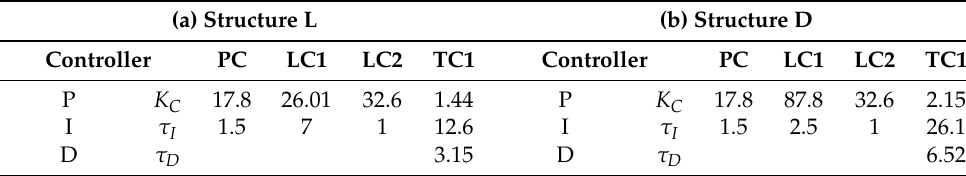
Table 5. Controller gain for the single temperature